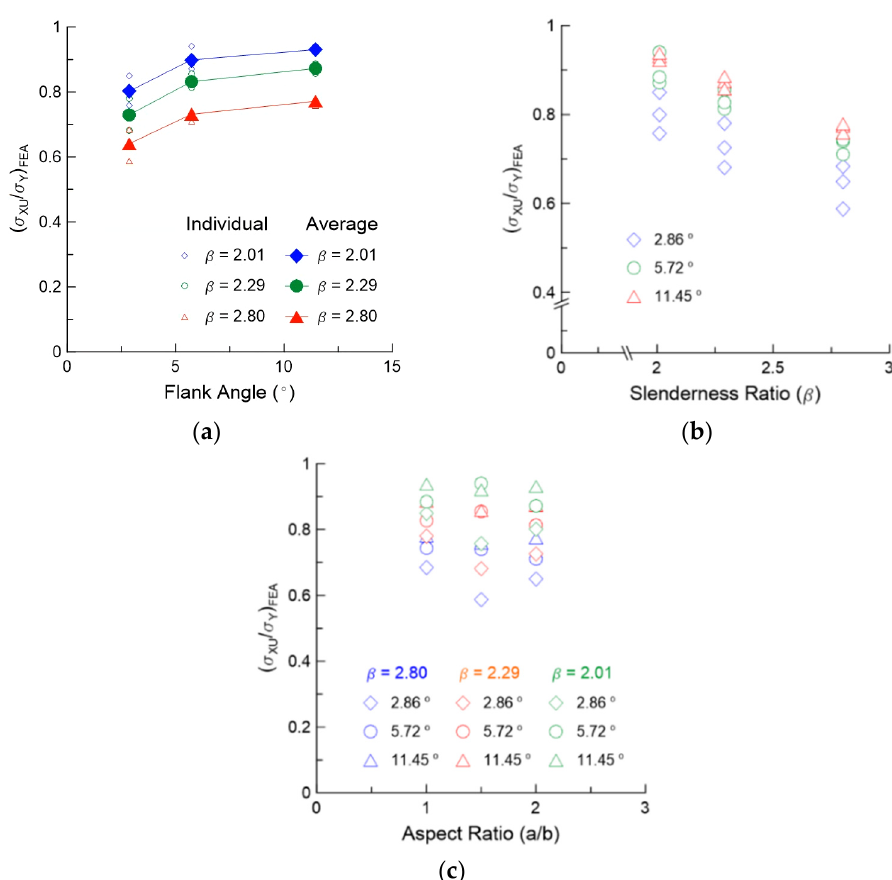
Figure 12. Ultimate strength of the curved plates based on the results of FE analysis: ( a ) effect of flank angle, ( b ) slenderness ratio, and ( c ) aspect ratio.